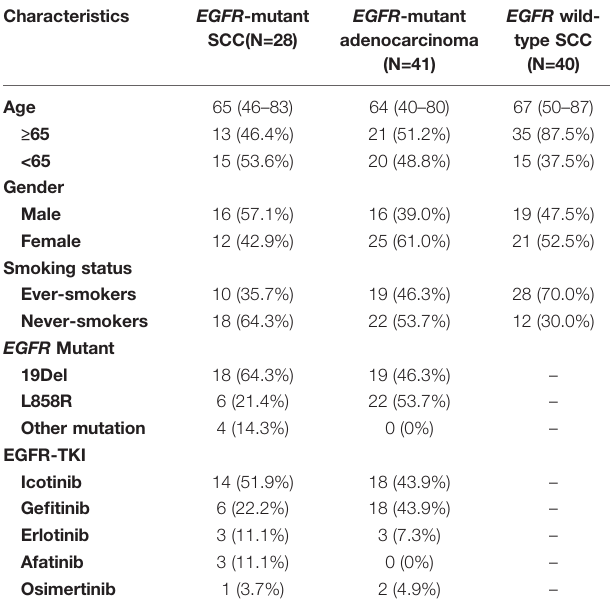
TABLE 1 | Baseline clinical characteristics of the study